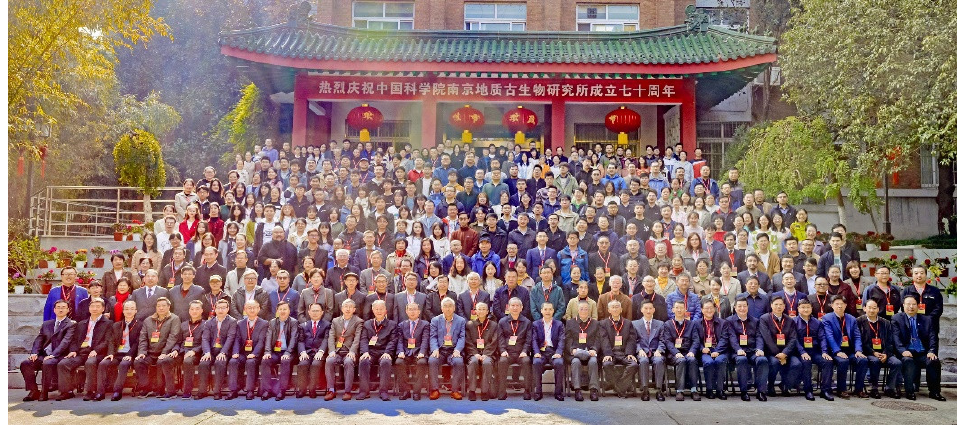
Figure 7. Group photo of participants of the conference celebrating the 70th anniversary of the Nan- jing Institute of Geology and Paleontology in Nanjing in 2021 (credit to NIGPAS). The Chinese char- acters means a warm congratulation to the 70th anniversary of the Nanjing Institute of Geology and Paleontology of the Chinese Academy of Sciences.